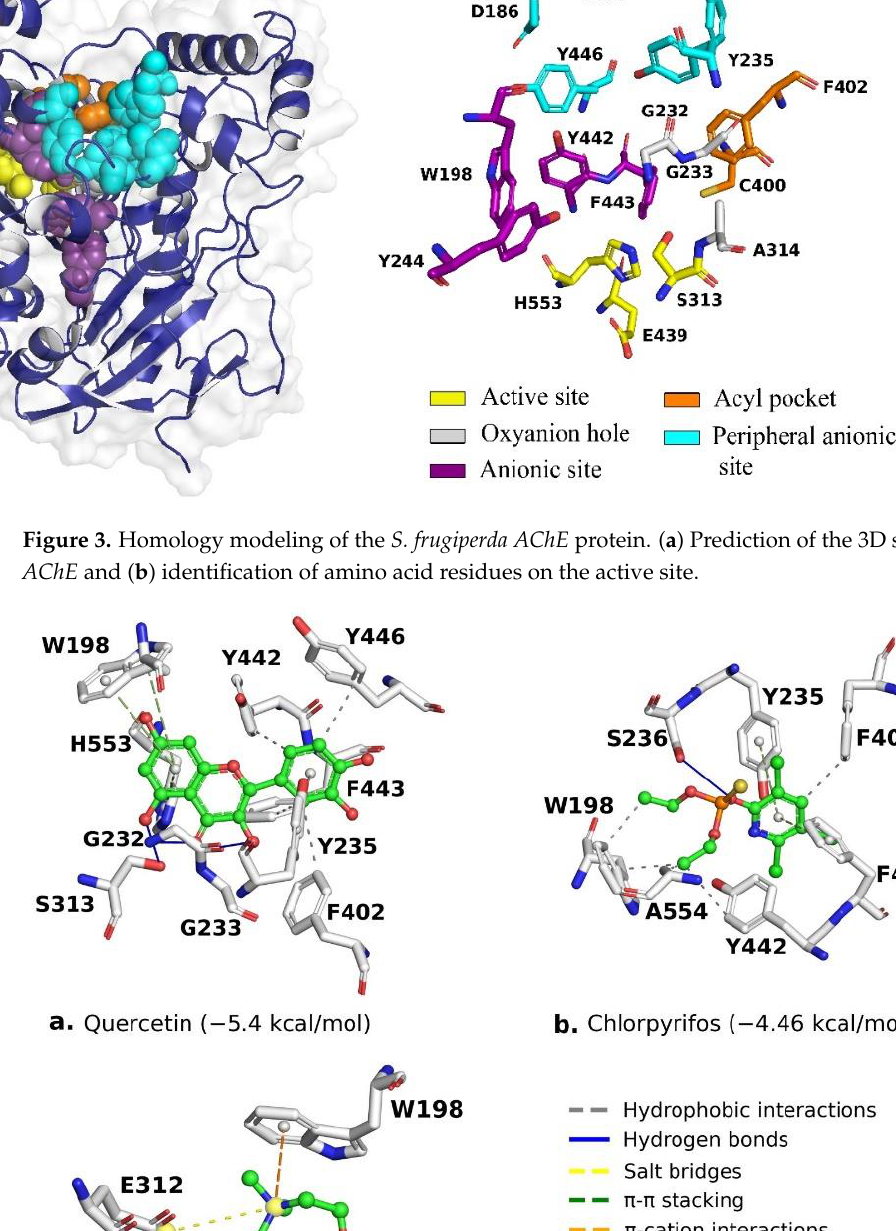
Figure 3 . Homology modeling of the S. frugiperda AChE protein. ( a ) Prediction of the 3D structure of AChE and ( b ) identification of amino acid residues on the active site.